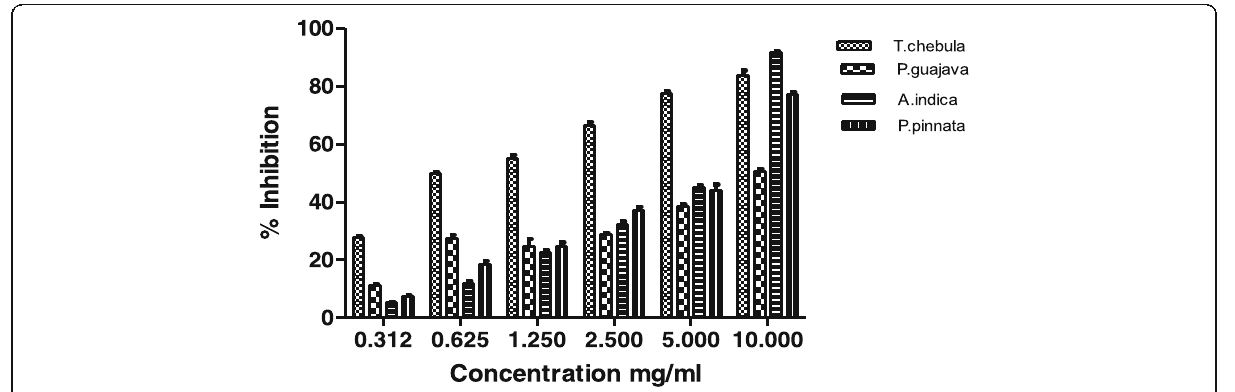
Fig. 1 Glucosultransferase inhibitory effects of T.chebula, P.guajava, A.indica and P.pinnata